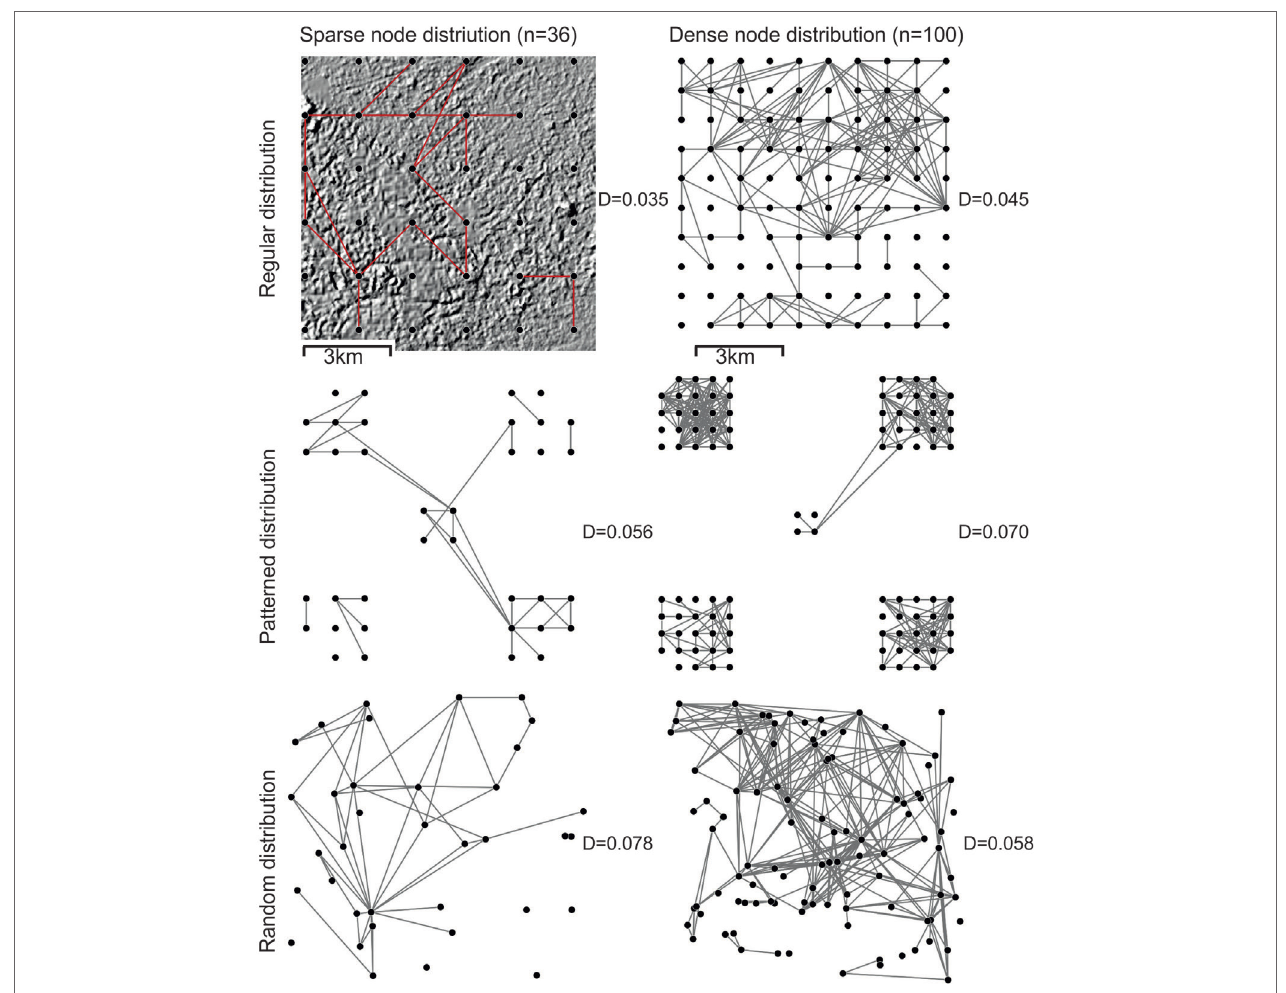
FigUre 9 | Densities (D) of visibility networks between differently distributed observation locations, with 10 m observer and target elevations, in a hilly landscape (Grande-Terre in Guadeloupe, French West Indies) of 9 km by 9 km. The following experiment settings were used for Figures 9 and 10 : maximum viewing distance = 5 km; curvature of the earth taken into account; elevation observation points = 10 m; elevation observed point = 10